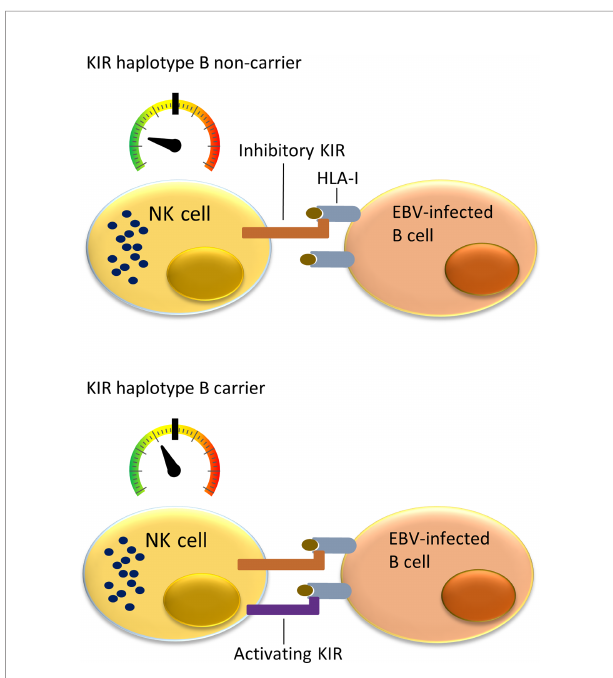
FIGURE 1 | Immune responses to EBV-infected B cells mediated by NK cells and cytotoxic T lymphocytes (CTLs) in KIR haplotype B carriers or non- carriers. NK cells in individuals not carrying KIR haplotype B often do not express a functional activating KIR receptor. The only activating KIR